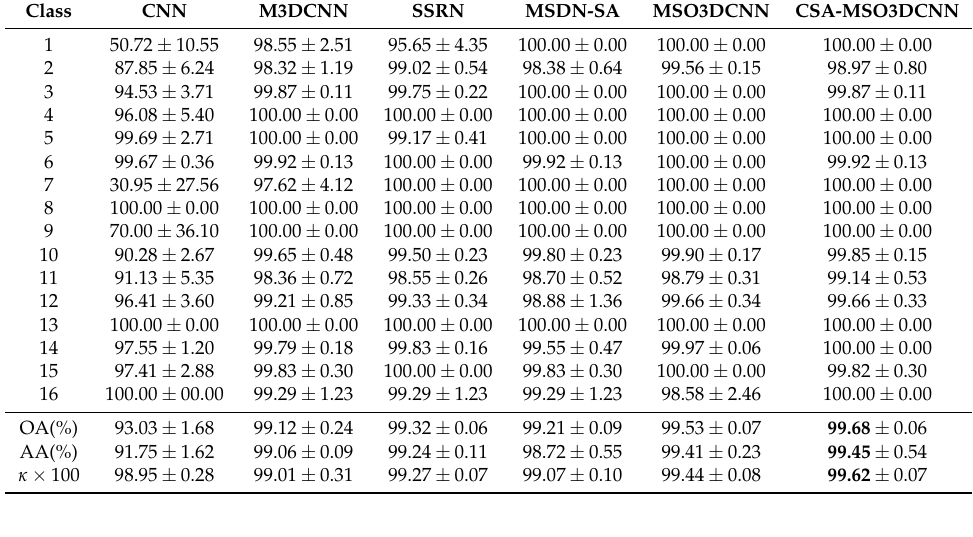
Table 5. Classification accuracy for the Indian Pines data set.